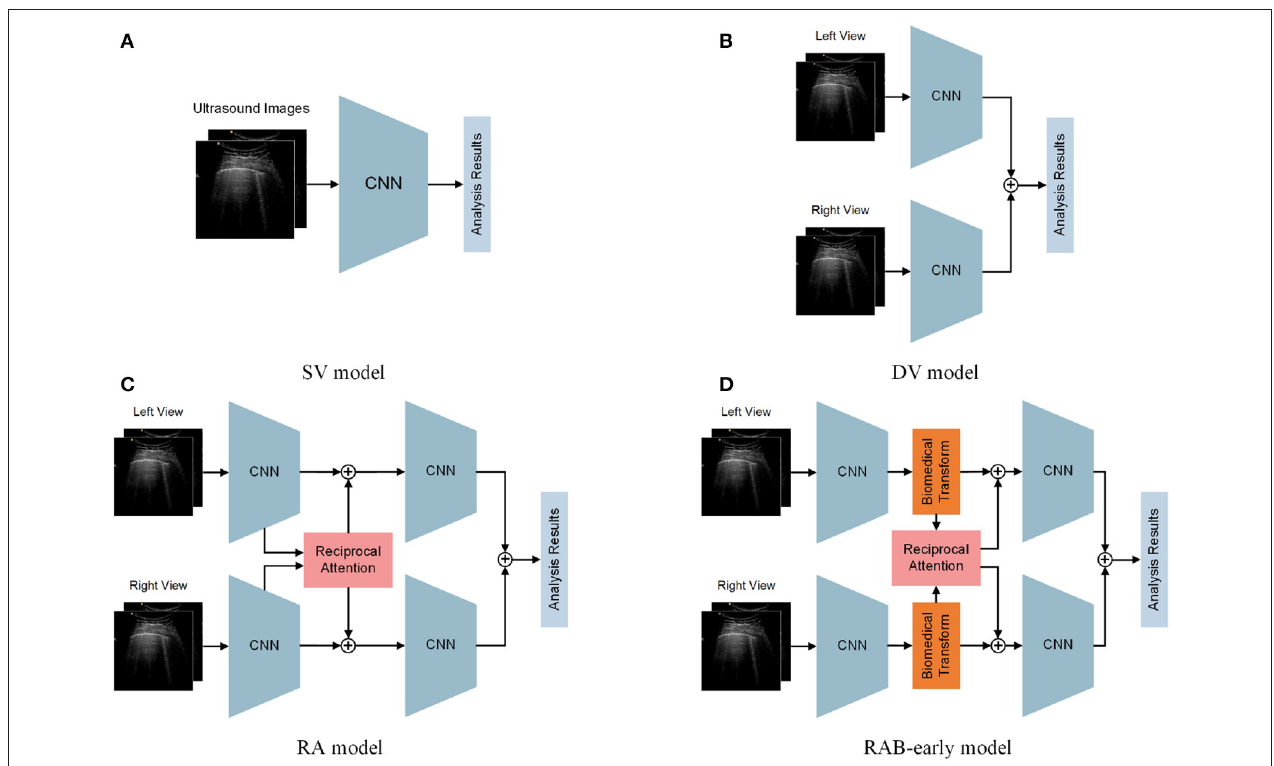
FIGURE 6 | Structures of baseline models. (A) Single view (SV) Model. (B) Dual view model without reciprocal attention module and biomedical transform module (DV) Model. (C) Reciprocal attention model without biomedical transform module (RA) Model. (D) Biomedical transform module before reciprocal attention module (named RAB-early)-early Model.